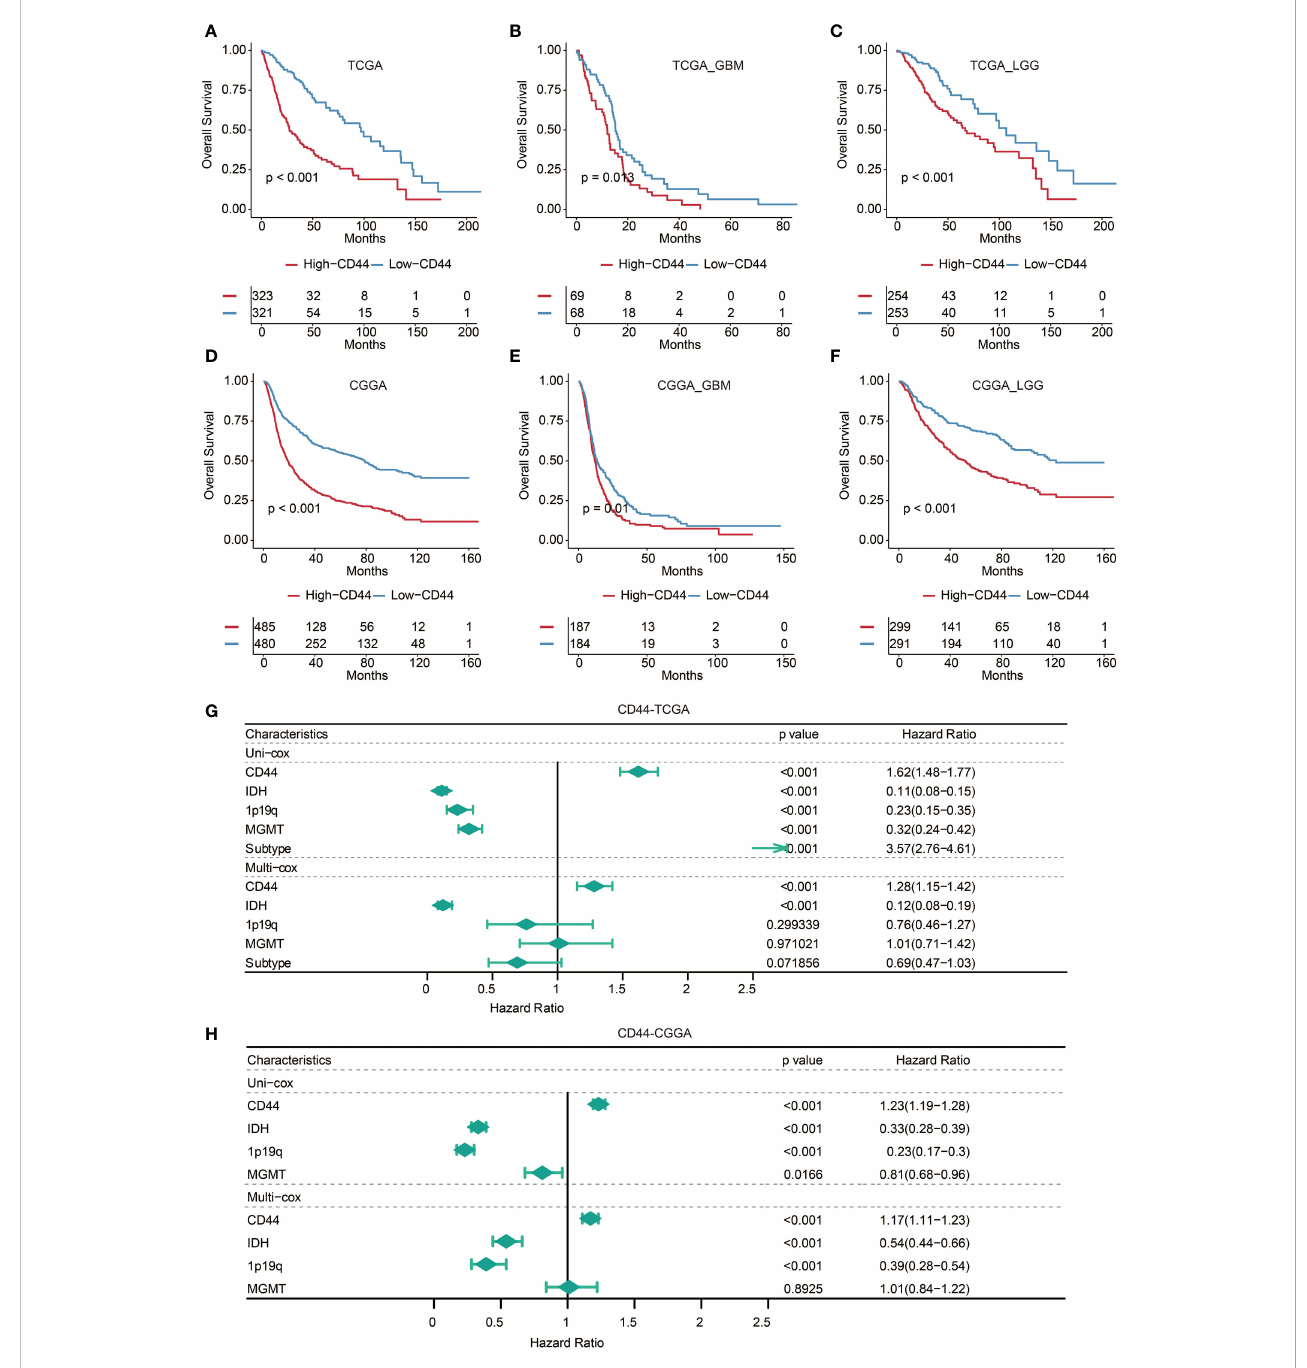
FIGURE 1 Higher CD44 expression is found in glioma patients with poor survival. Kaplan-Meier analysis of OS based on high vs. low expression of CD44 in the TCGA (A-C) and CGGA (D-F) datasets. The median value of CD44 was used as the cut-off value. P-values were obtained from the log-rank test. (G) Univariate and multivariate Cox regression analysis on clinical factors in the TCGA dataset. (H) Univariate and multivariate Cox regression analysis on clinical factors in the CGGA